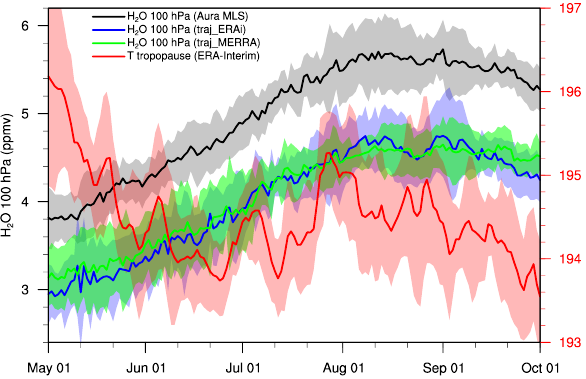
Figure 1. Climatological 100hPa water vapor observed by the Aura MLS (black) and simulated by the traj_ERAi (blue) and traj_MERRA (green). The time series were averaged over the Asian monsoon region (20–40 ◦ N, 40–140 ◦ E) during May–September, 2005–2013. The red line denotes the time series of tropopause tem- peratures averaged over the same domain as in R15 (15–30 ◦ N, 70– 120 ◦ E), calculated based on the World Meteorological Organiza- tion (WMO) tropopause definition. The shadings indicate the corre- sponding standard deviation